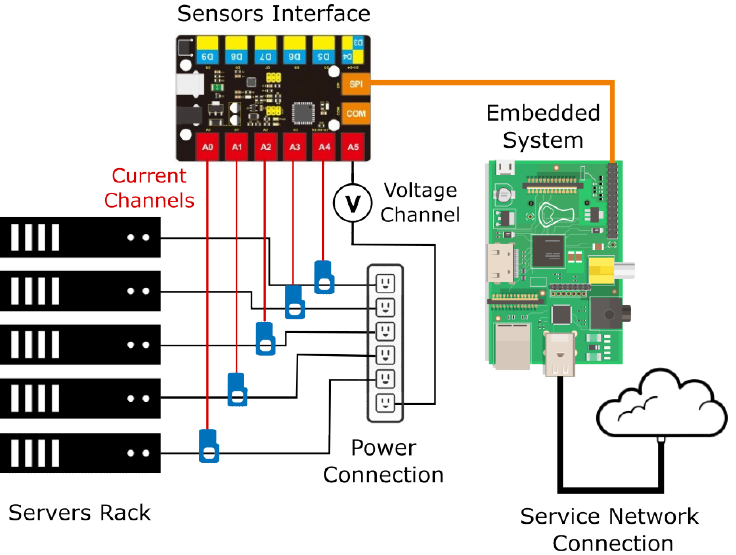
Figure 2. Architecture diagram of the measurement system.